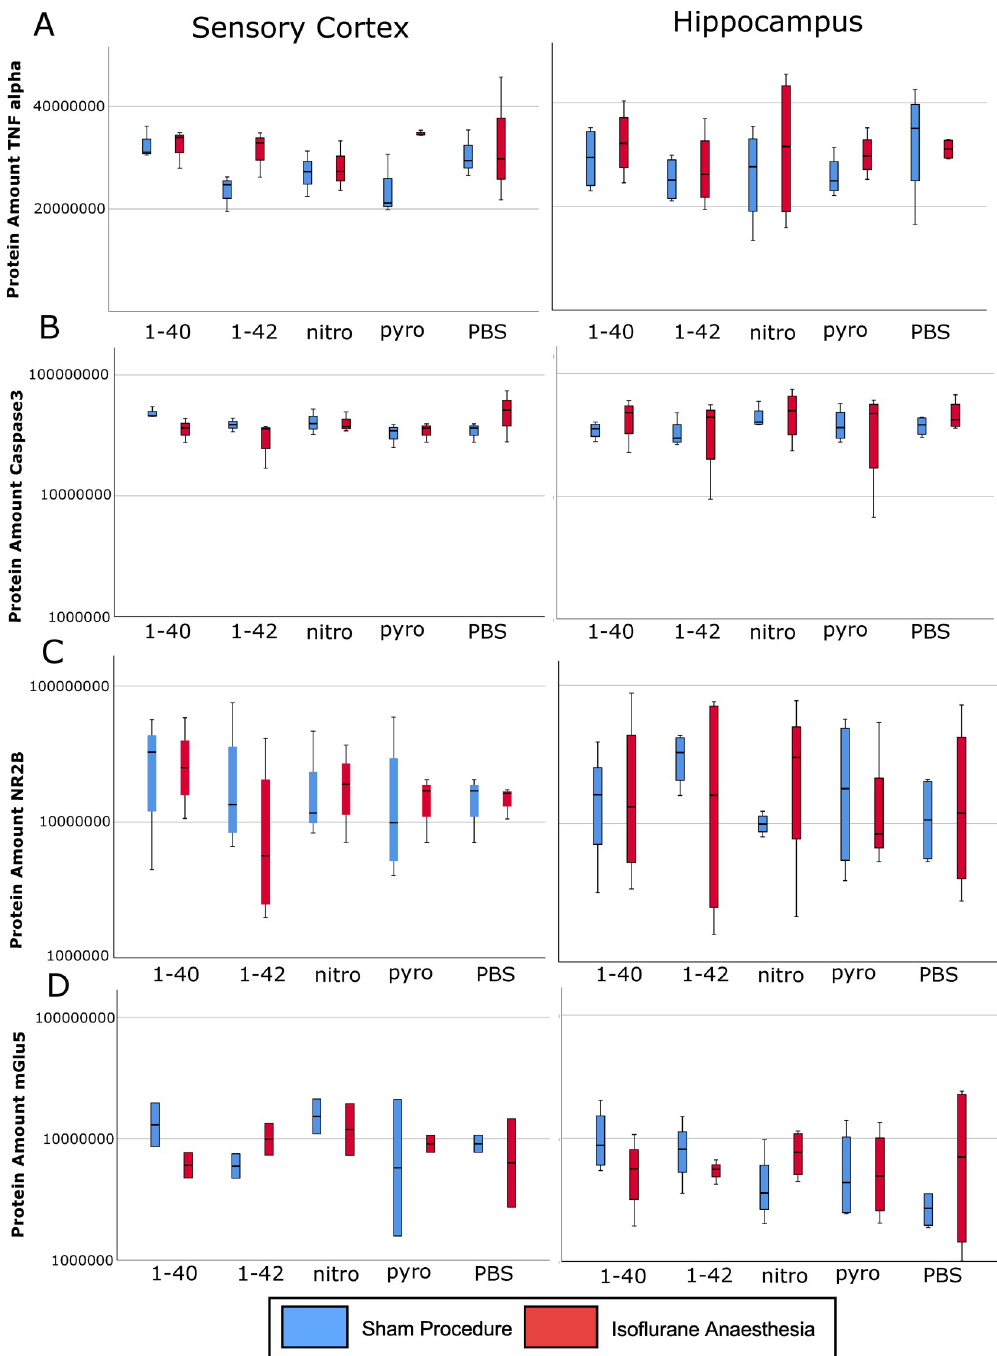
Fig 4. Total protein amount in sensory cortex and hippocampus. A: Tumor necrosis factor alpha (TNF alpha), B: Caspase 3, C: N-methyl-D-aspartate receptor subunit 2B (NR2B); D: Metabotropic glutamate receptor 5 (mGlu5); median (horizontal lines), interquartile range (box) and range